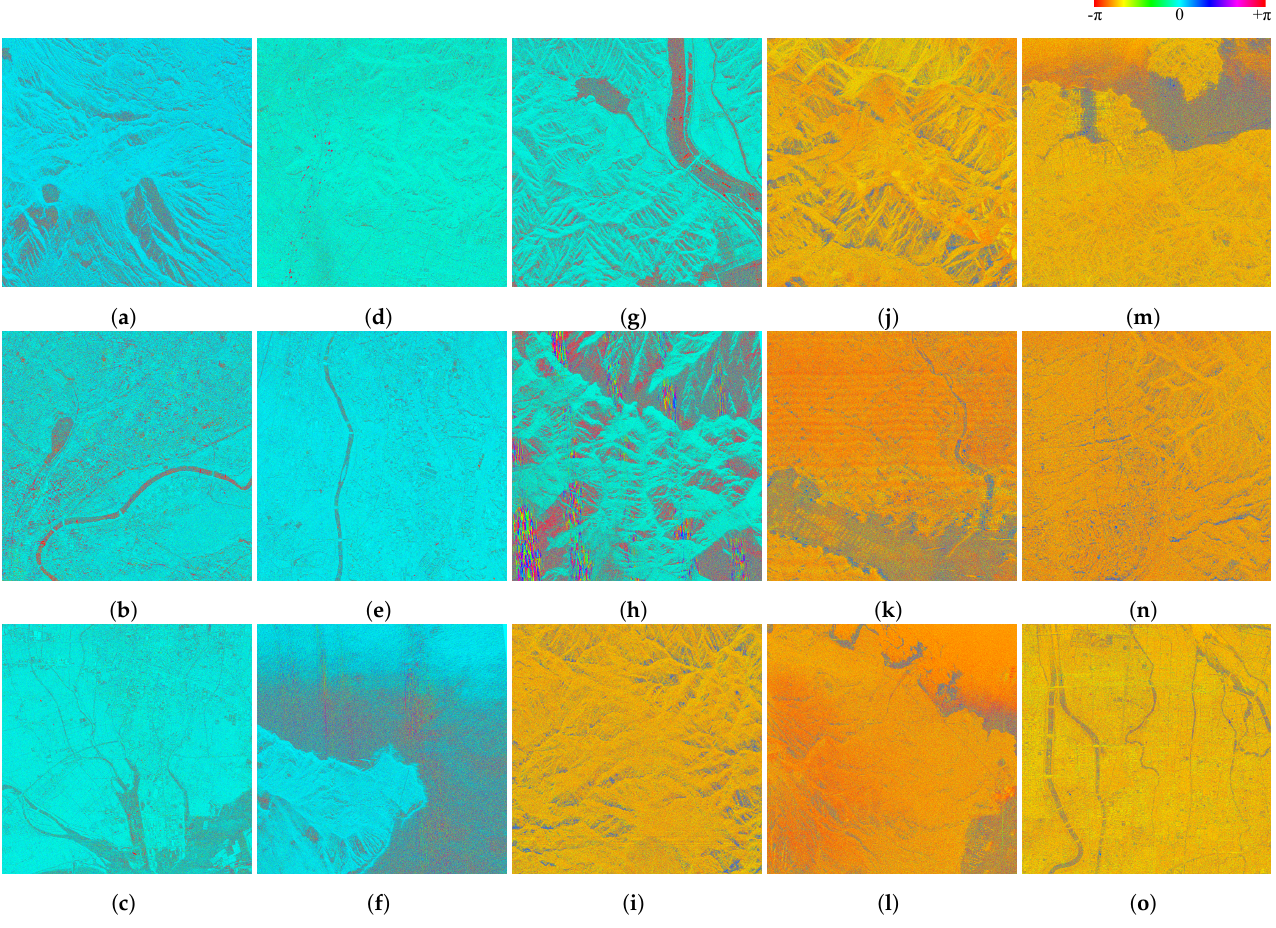
Figure 7. Phase differences of HV and VH for each observation series. ( a ) 2011-02-22. ( b ) 2011-08-26. ( c ) 2011-10-06. ( d ) 2012-01-11. ( e ) 2012-11-02. ( f ) 2013-01-11. ( g ) 2013-08-26. ( h ) 2013-10-17. ( i ) 2014- 08-22. ( j ) 2015-02-12. ( k ) 2015-02-05. ( l ) 2015-12-06. ( m ) 2016-04-17. ( n ) 2016-10-13. ( o )